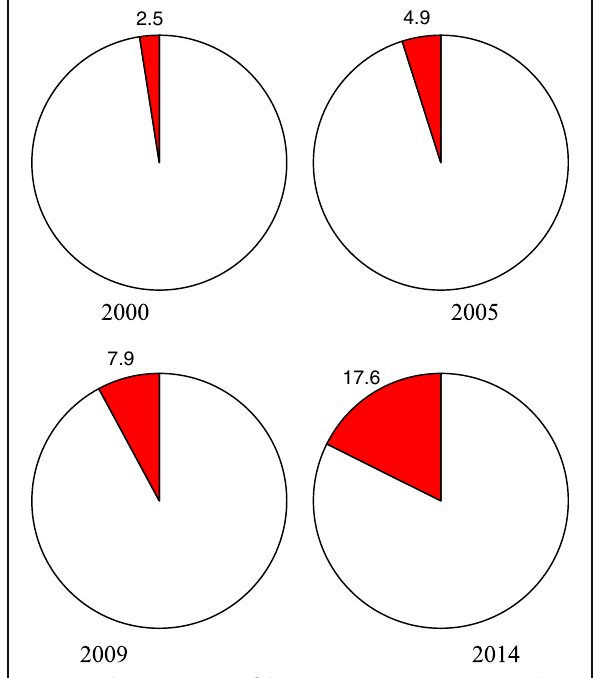
Figure 3 The percentages of the LSMA in 2000, 2005, 2009, and 2014 in Butana